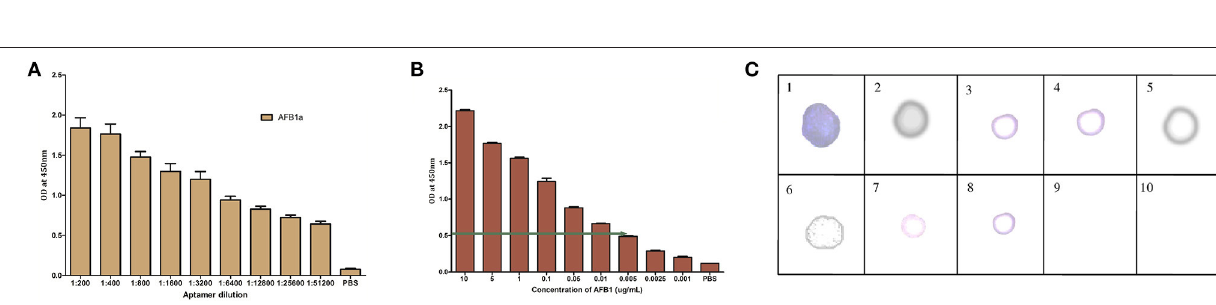
FIGURE 3 | Characterization of selected AFB1a aptamer. (A) The AFB1a aptamer titre values determined through indirect ELISA. (B) Limit of detection analysis by indirect ELISA of AFB1a aptamer against various AFB1 concentration from 10–0.001 µ g/mL. (C) Specificity analysis of AFB1a aptamer determined by dot-ALISA,